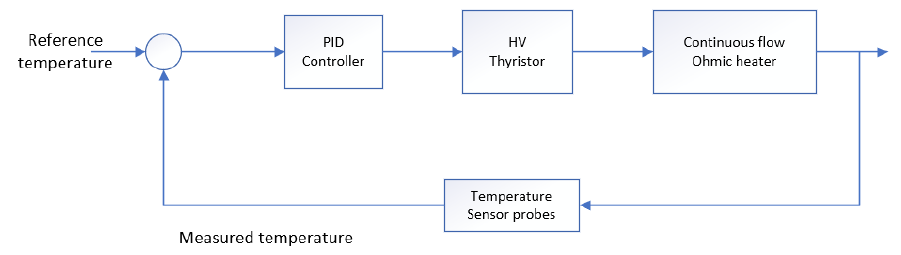
Figure 3. Closed loop PID control of the continuous flow ohmic heater.